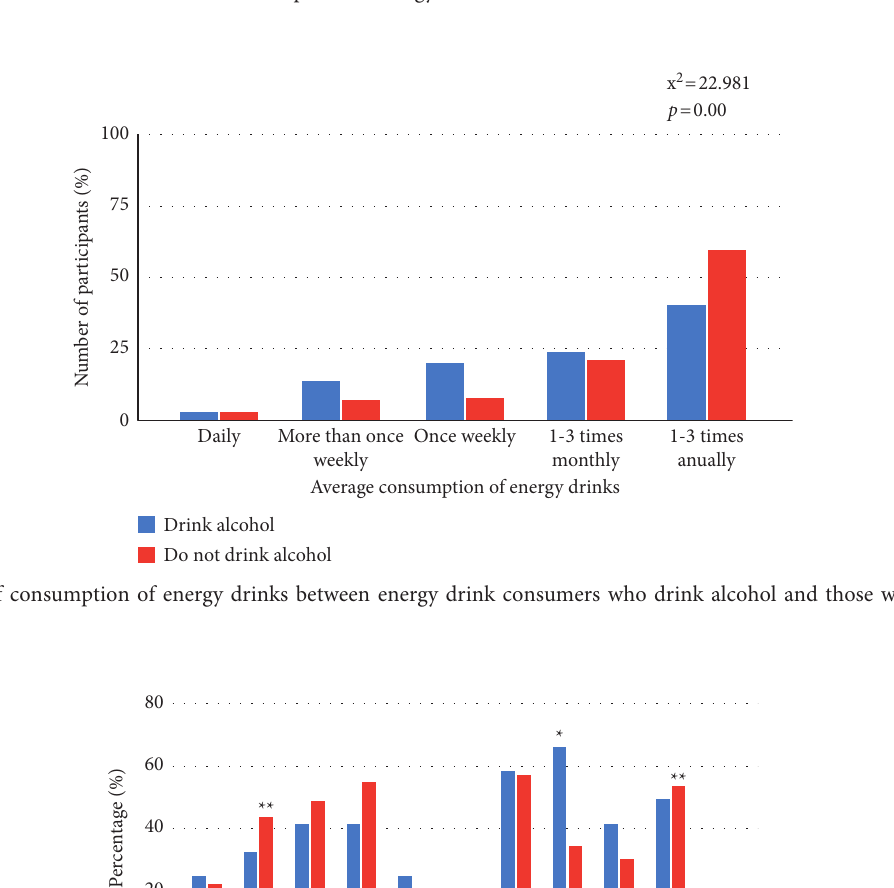
Figure 1: Pattern of consumption of energy drinks between smokers and non-smokers.